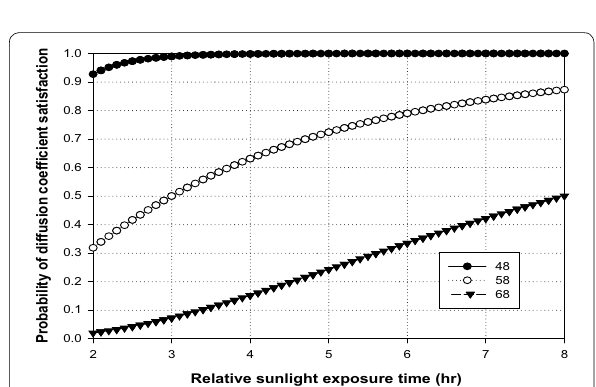
Fig. 8 Satisfaction Curve of sunlight exposure time parameter for combine chloride diffusion coefficient rate (48, 58,